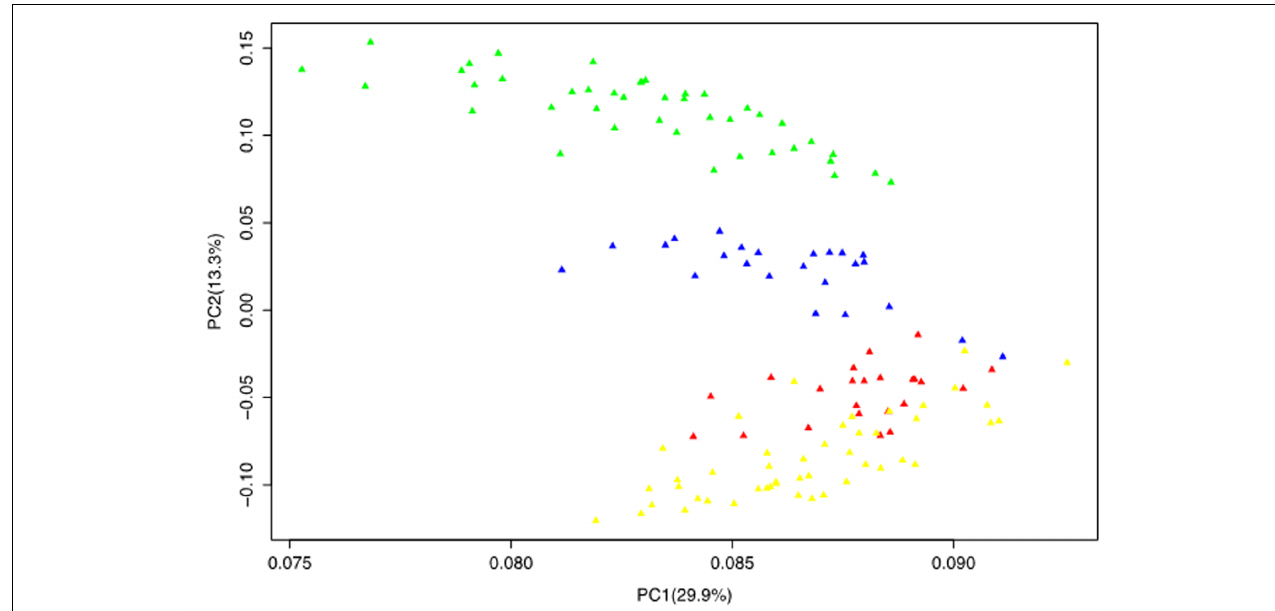
FIGURE 3 | Principal component analysis results based on genotypic data of 50 SSR markers. The color codes are the same as those presented in the STRUCTURE ( Figure 1 ) and NJ tree ( Figure 2 ).